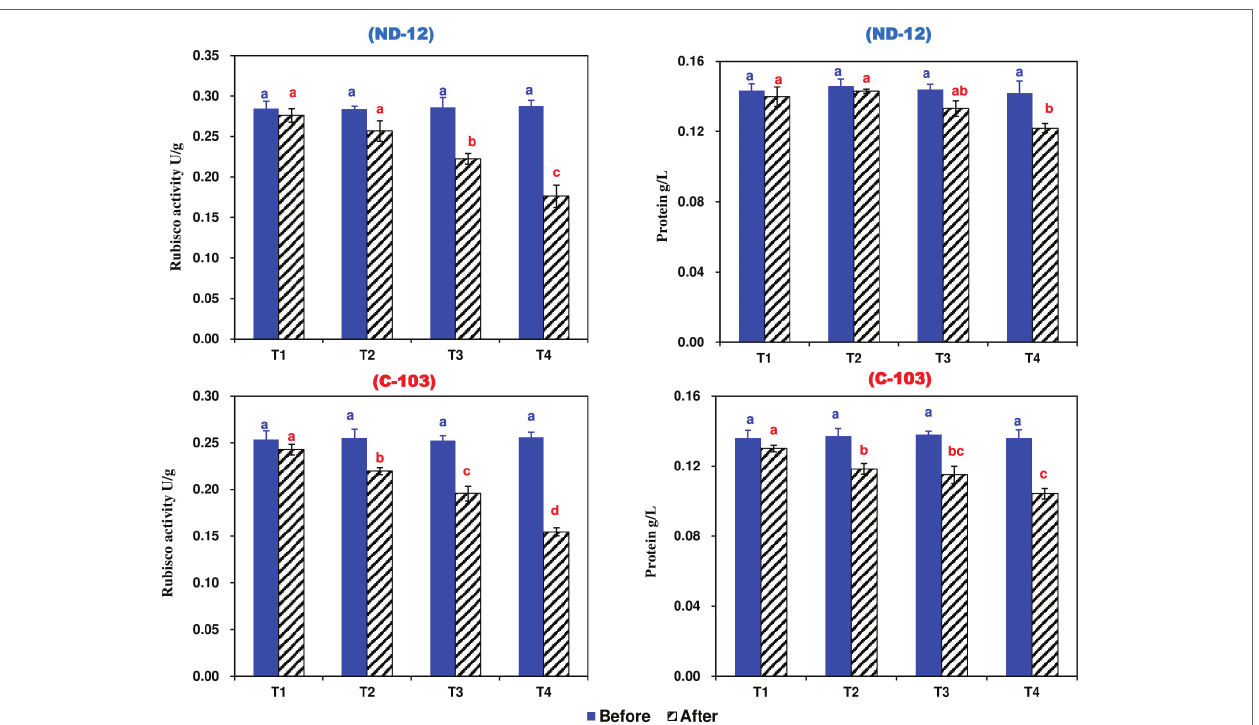
FIGURE 5 | Effect of different split-root PEG treatments on Rubisco activity and total soluble protein of two soybean cultivars, ND-12 (drought-resistant) and C-103 (drought-susceptible). (Mean ± SE), same small letters are not significantly different at p < 0.05. T1 (0%: 0%), T2 (2%A: 0%B), T3 (6%A: 0%B), and T4 (4%A: